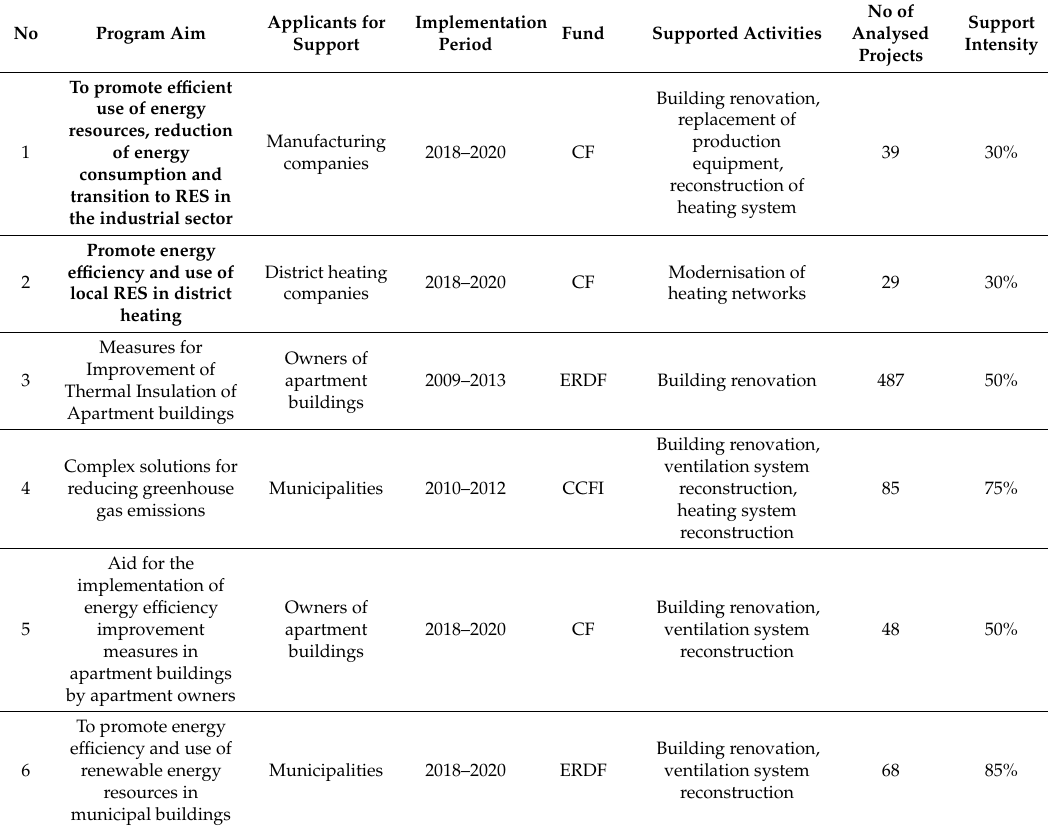
Table 2. Overview on analysed policy programs related to energy e ffi ciency